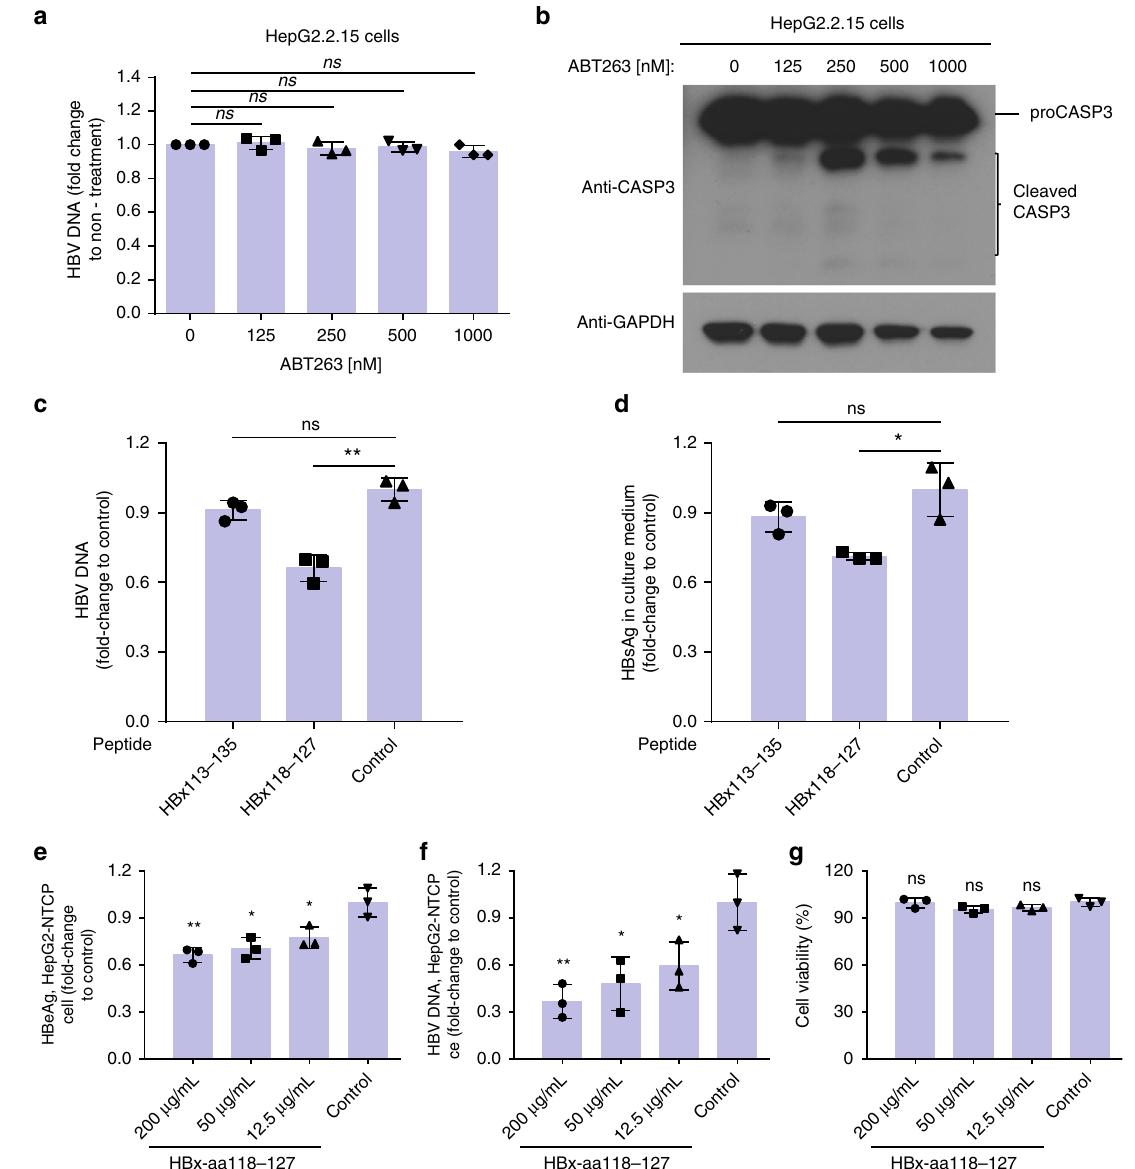
Fig. 6 The HBx-aa118 – 127 peptide, but not ABT-263, inhibits HBV replication and transcription in HepG2.2.15 cells. a HepG2.2.15 cells were treated with 125, 250, 500, and 1000 nM of ABT-263 for 2 days. Cytoplasmic HBV viral particles were isolated and the viral DNA replication intermediates were quanti fi ed (Methods). The results represent the fold change of the replicative intermediates in HepG2.2.15 cells from the indicated treatments, compared with those without treatment. b HepG2.2.15 cells were treated with the indicated concentrations of ABT-263 for 2 days. The lysate was analyzed by immunoblotting using antibodies to caspase-3 (CASP3) and GAPDH (glyceraldehyde 3-phosphate dehydrogenase). c , d The HBx-aa113 – 135, HBx- aa118 – 127, or the control peptides were delivered into HepG2.2.15 cells using PEP-1 nanoparticles (Methods). The levels of HBV DNA ( c ) and the levels of HBV S-antigen (HBsAg) expression ( d ) in culture medium collected from HepG2.2.15 cells were measured (Methods). The results are shown as fold change compared to that of the control peptide. e – g HepG2-NTCP cells were transfected with HBx118 – 127 peptide with concentration of 12.5, 12.5, and 50 μ g/ml or unrelated control peptide during HBV infection (multiplicity of infection (MOI) = 200), respectively. e HBV e-antigen (HBeAg), f HBV DNA, and g cell viability were measured at day 8 after HBV infection. Data shown represent mean ± SD. Signi fi cance is indicated on the top. Not signi fi cant (ns): * P < 0.05, ** P < 0.01; two-tailed unpaired t tests (n = 3 biologically independent samples). Source data are provided as a Source Data fi